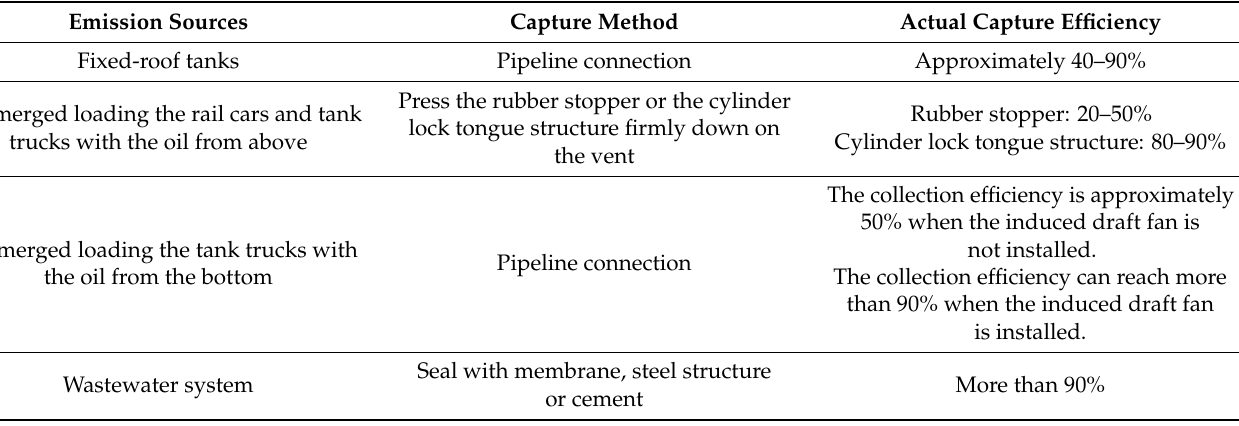
Table 5. Summary of capture efficiency in the PR industry in China.